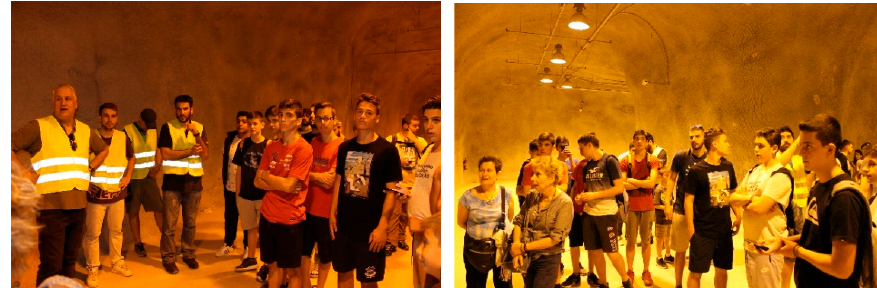
Figure 9. Participant arrival in the underground area.